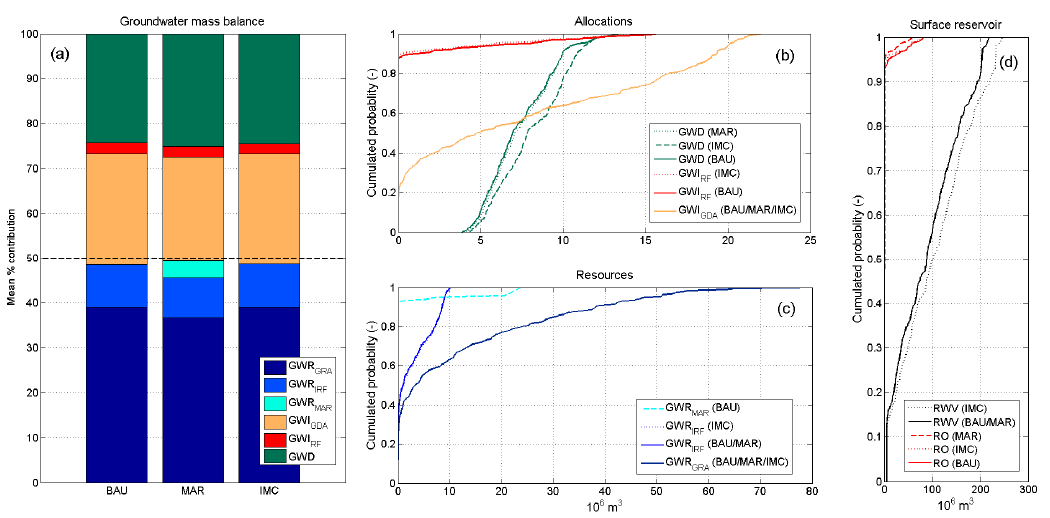
Figure 5. Panel ( a ): absolute percentage contribution to the aquifer mass balance for each scenario. Natural recharge to aquifer (GWR GRA ), recharge due to irrigation return flow (GWR IRF ) and managed aquifer recharge (GWR MAR ), direct abstraction from the aquifer (GWI GDA ), abstraction due to surface reservoir shortage (GWI RF ), and discharge to sea are (GWD). By construction, the 50% line indicates equilibrium between Resources (cold colors) and Allocations (hot and green colors) components. Panel ( b ) cumulated density function of allocations for each adaptation scenario. Panel ( c ): cumulated density function of resources for each adaptation scenario. Panel ( d ): cumulated density function of the Occhito surface reservoir volume (RWV) and overflow (RO). Table 3. Annual cumulated mean water volume (Mm 3 ) of each term of the groundwater mass balance and mean water volume (106 m 3 ) for the surface reservoir (RWV) and the groundwater (GWV) for hindcast scenario over the period 1981–2010.